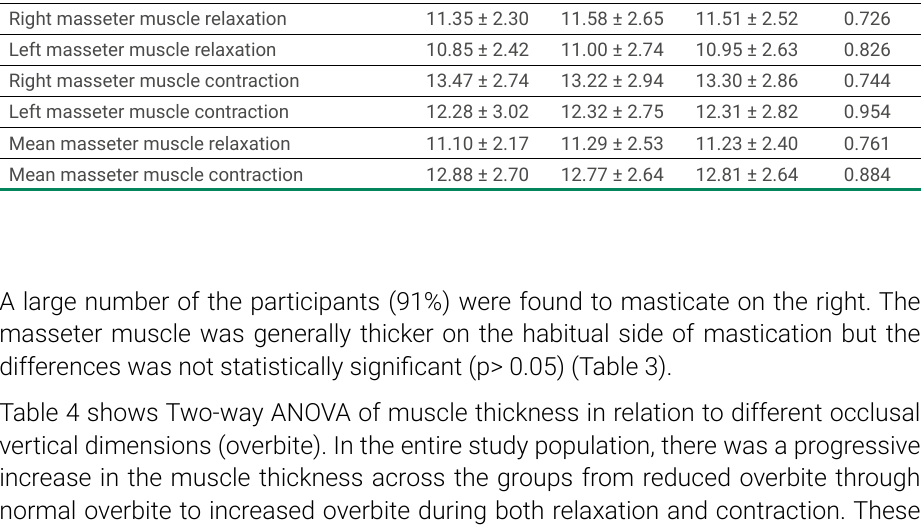
Table 2. Gender distribution of masseter muscle thickness during relaxation and Contraction phases Characteristics of participants